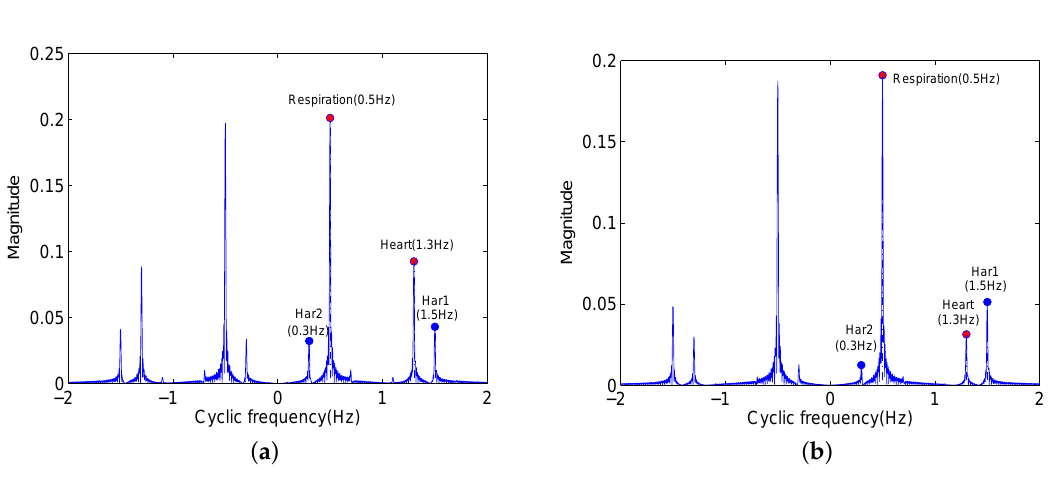
Figure 2. TOCC of B ( t ) in (5). ( a ) TOCC of the received signal; ( b ) TOCC of the received signal (here a h = 0.02